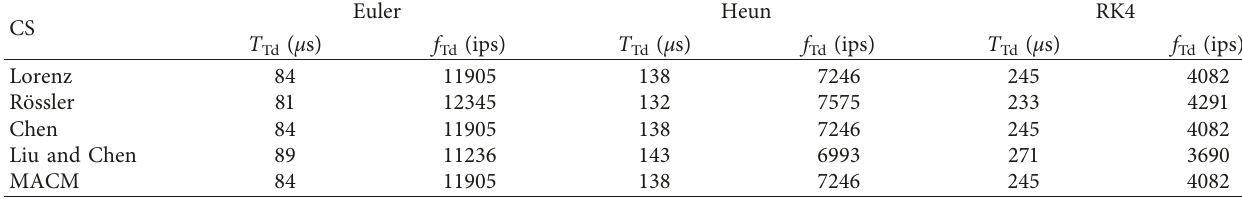
Table 8: Performance of ES in the V2 of the 3D Lorenz, R¨ossler, Chen, Liu and Chen, and MACM CSs in their DVs by using Euler (6), Heun (7) and (8), and RK4 (9)–(13) NAs.